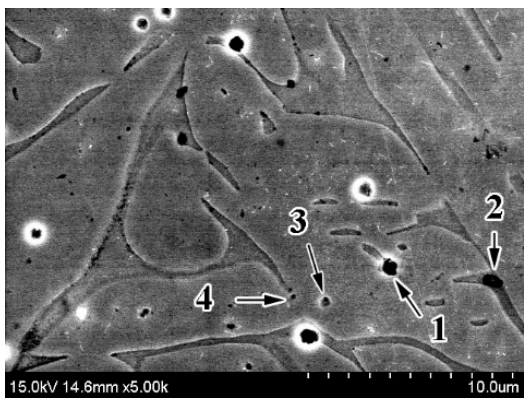
Figure 11. The SEI micrographs of the GTAW weld. Table 4. EDS compositional analysis (wt %) of the GTAW weld.